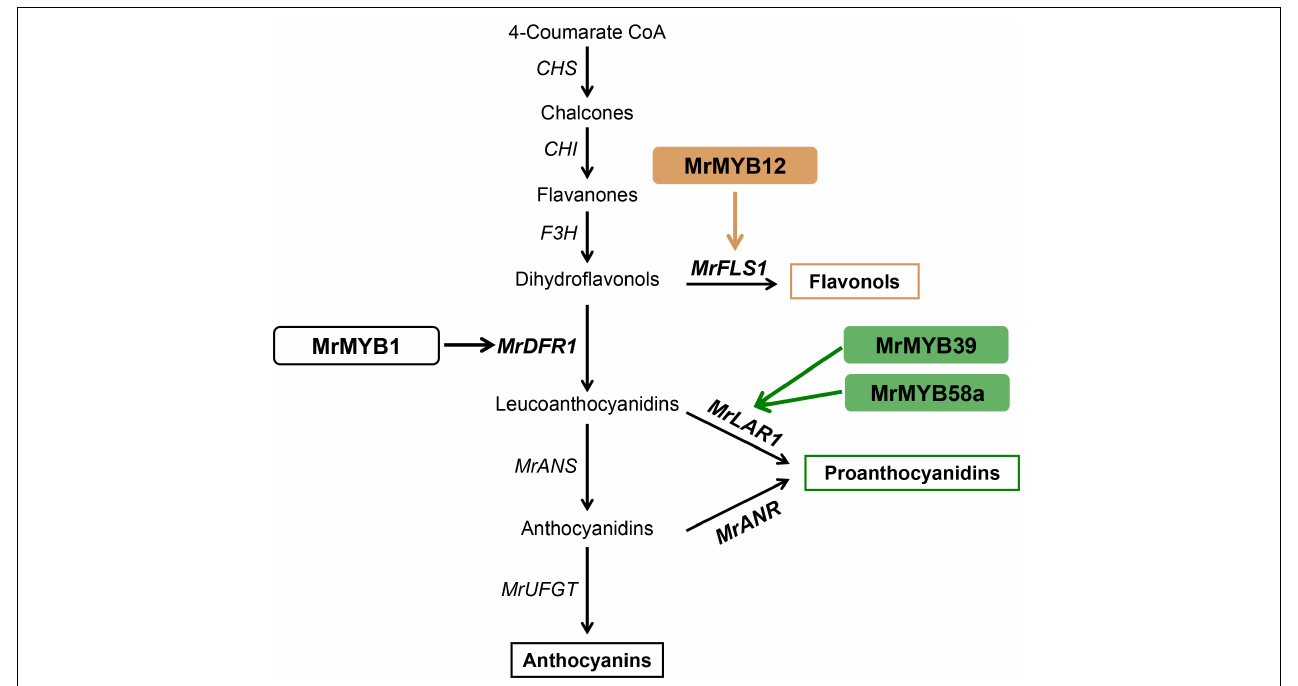
FIGURE 8 | A proposed model for MYB-regulated flavonoid biosynthesis in Chinese bayberry. MrMYB12 activates the expression of MrFLS1 to regulate flavonol accumulation. The brown and blue arrows indicate the pathways verified in the present work. The black arrows indicate the pathways that have been previously reported in Chinese bayberry. CHS, chalcone synthase; CHI, chalcone isomerase; F3H, flavanone-3- O -hydroxylase; DFR, dihydroflavonol-4-reductase; FLS, flavonol synthase; ANS, anthocyanidin synthase; LAR, leucoanthocyanidin reductase; ANR, anthocyanidin reductase; UFGT, UDP-glucose:flavonoid 3- O